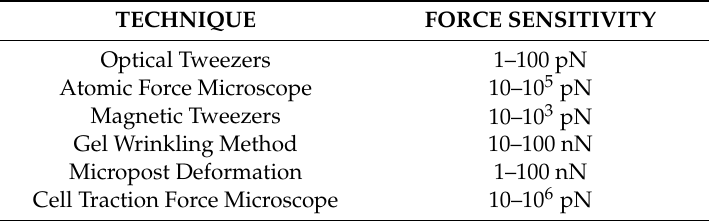
Table 1. Force Sensitivity of Cellular Forces Measured with Selective Cell Mechanics